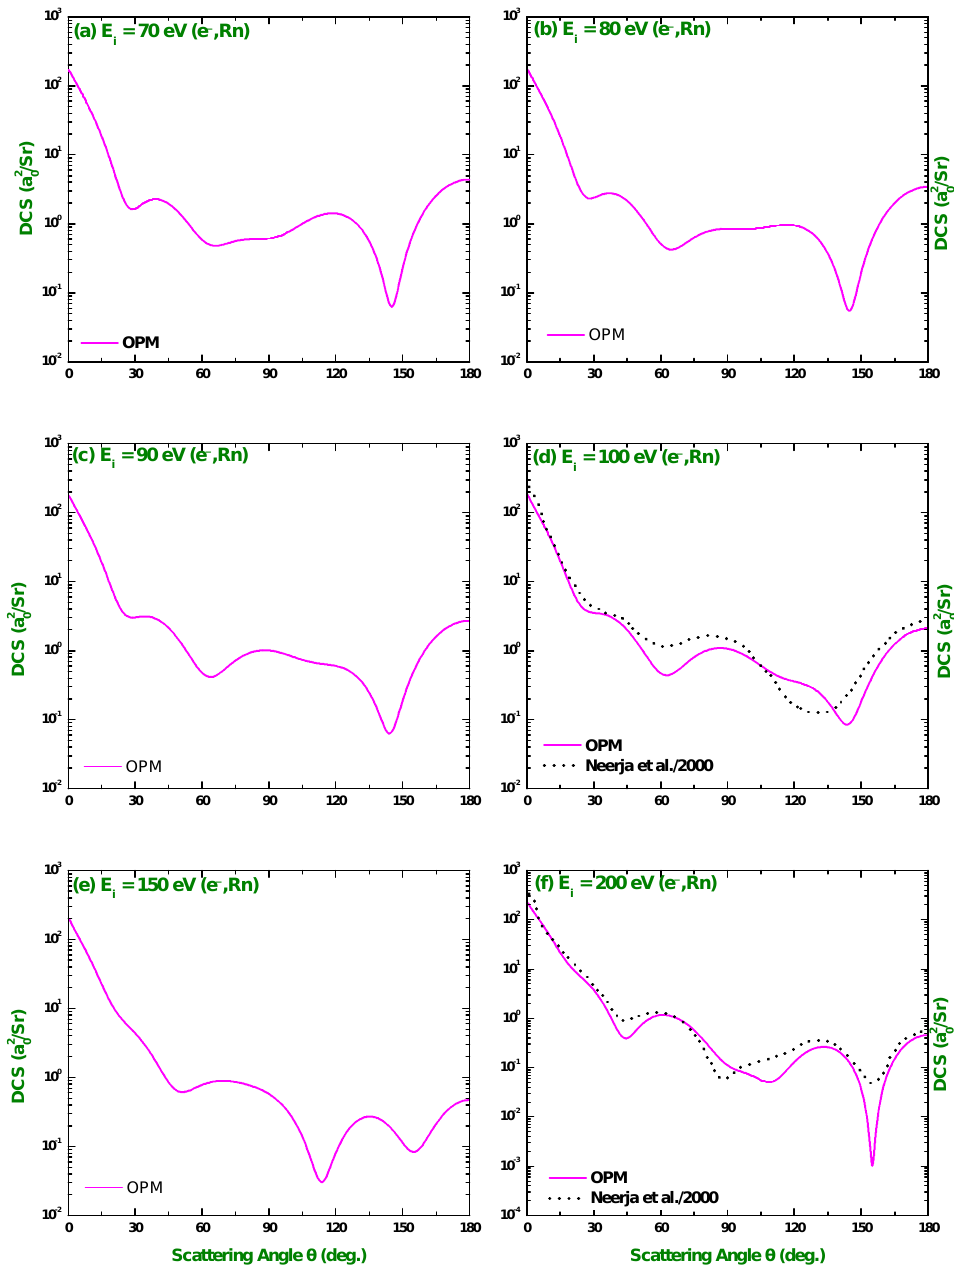
Figure 7. Angular dependence of the differential cross section of electrons scattering from 222 Rn at E i = 70, 80, 90, 100, 150 and 200 eV. Included are the results from Neerja et al. [19] ( · · · · · · ) at 100 and 200